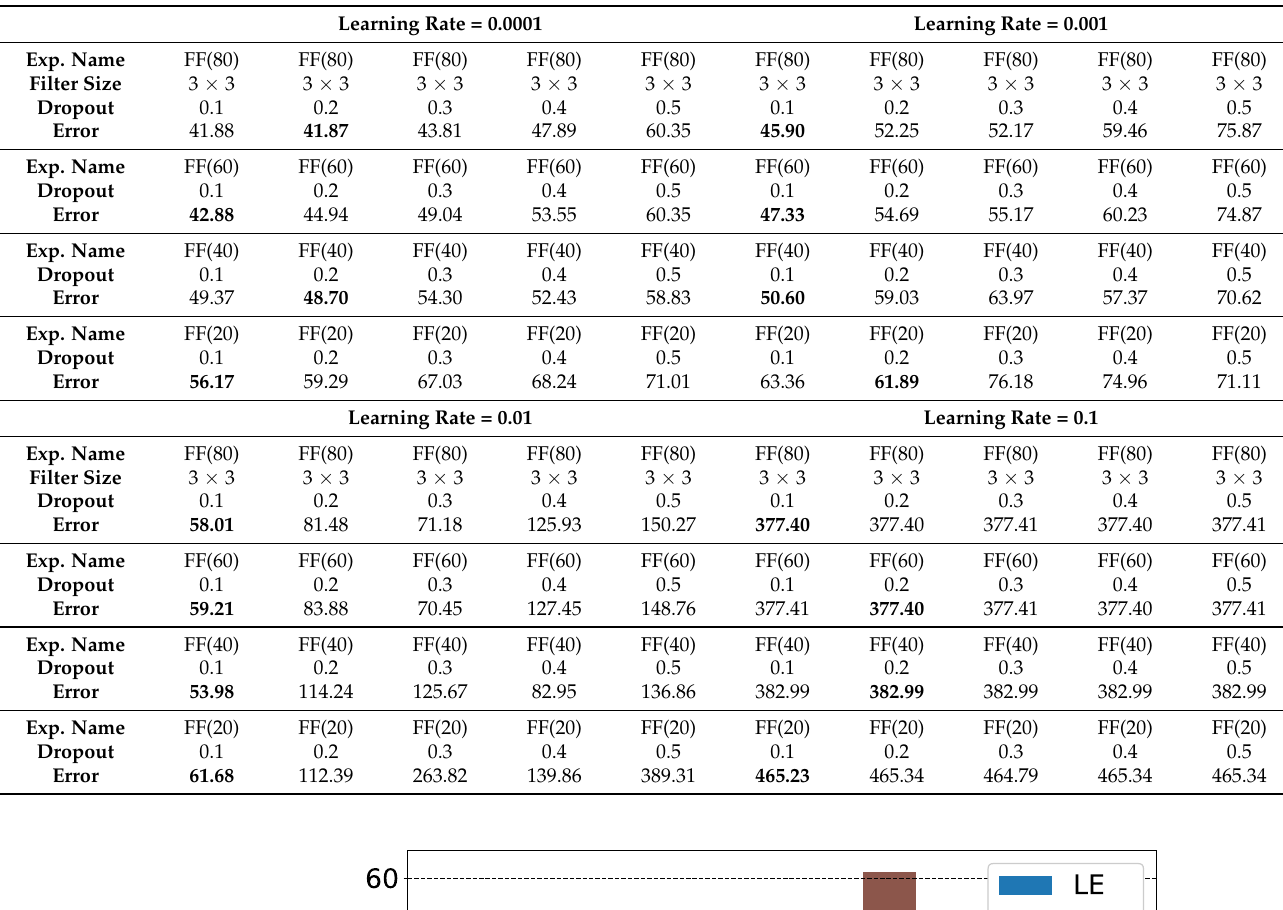
Table 8. Results of different training sets on face data.